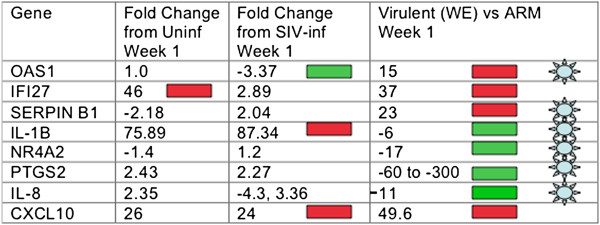
Gene expression of SIV-infected monkeys given the ML29 Lassa vaccine. Column one has the Genbank gene name. Column two has the fold difference in gene expression between ML29-vaccinated and uninfected (no SIV) monkeys, week 1. Column three has the fold difference in gene expression between ML29-vaccinated and SIV-infected, week 1. Column four has week one gene expression data from our previous profiling of monkeys inoculated with virulent and non-virulent strains of LCMV [35]. The blue star indicates indicates potential virulence markers in primate and guinea pig infections with virulent/mild virus pairs.